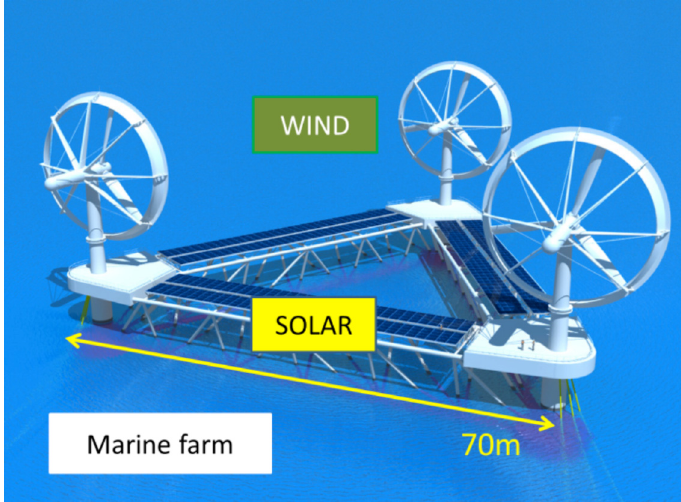
Fig. 9. Concept image of the next generation mid-size offshore hybrid energy farm (second stage). A side spans about 70 m to form a triangular platform hosting three 300 kW Wind lens turbines and PV panels making total rated output as large as 1 MW